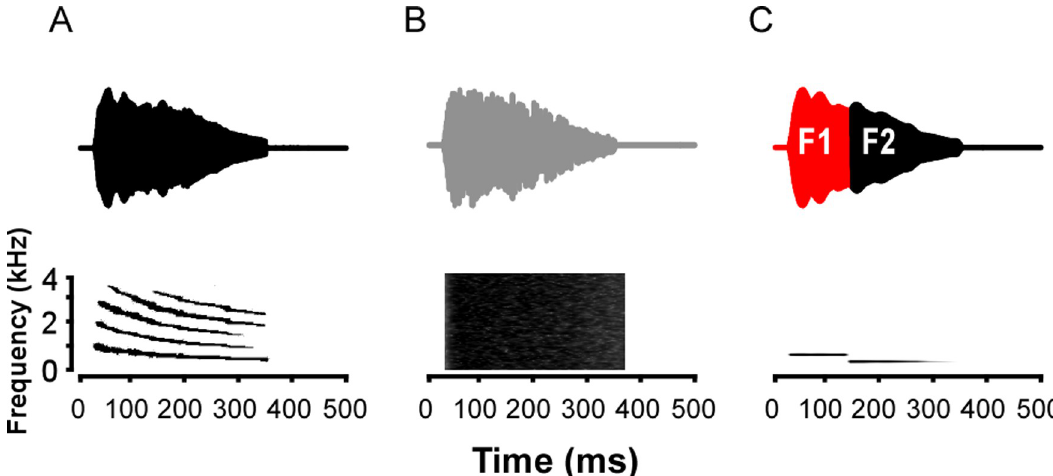
Fig 1. Examples of stimuli. Upper and lower rows are time waveforms and spectrograms, respectively, for three of the stimuli used to test auditory sensitivity in isolated units of the mid-brain. (A) whine; (B) broadband noise with whine envelope; (C) two tone FM step (800 to 500 Hz) with whine